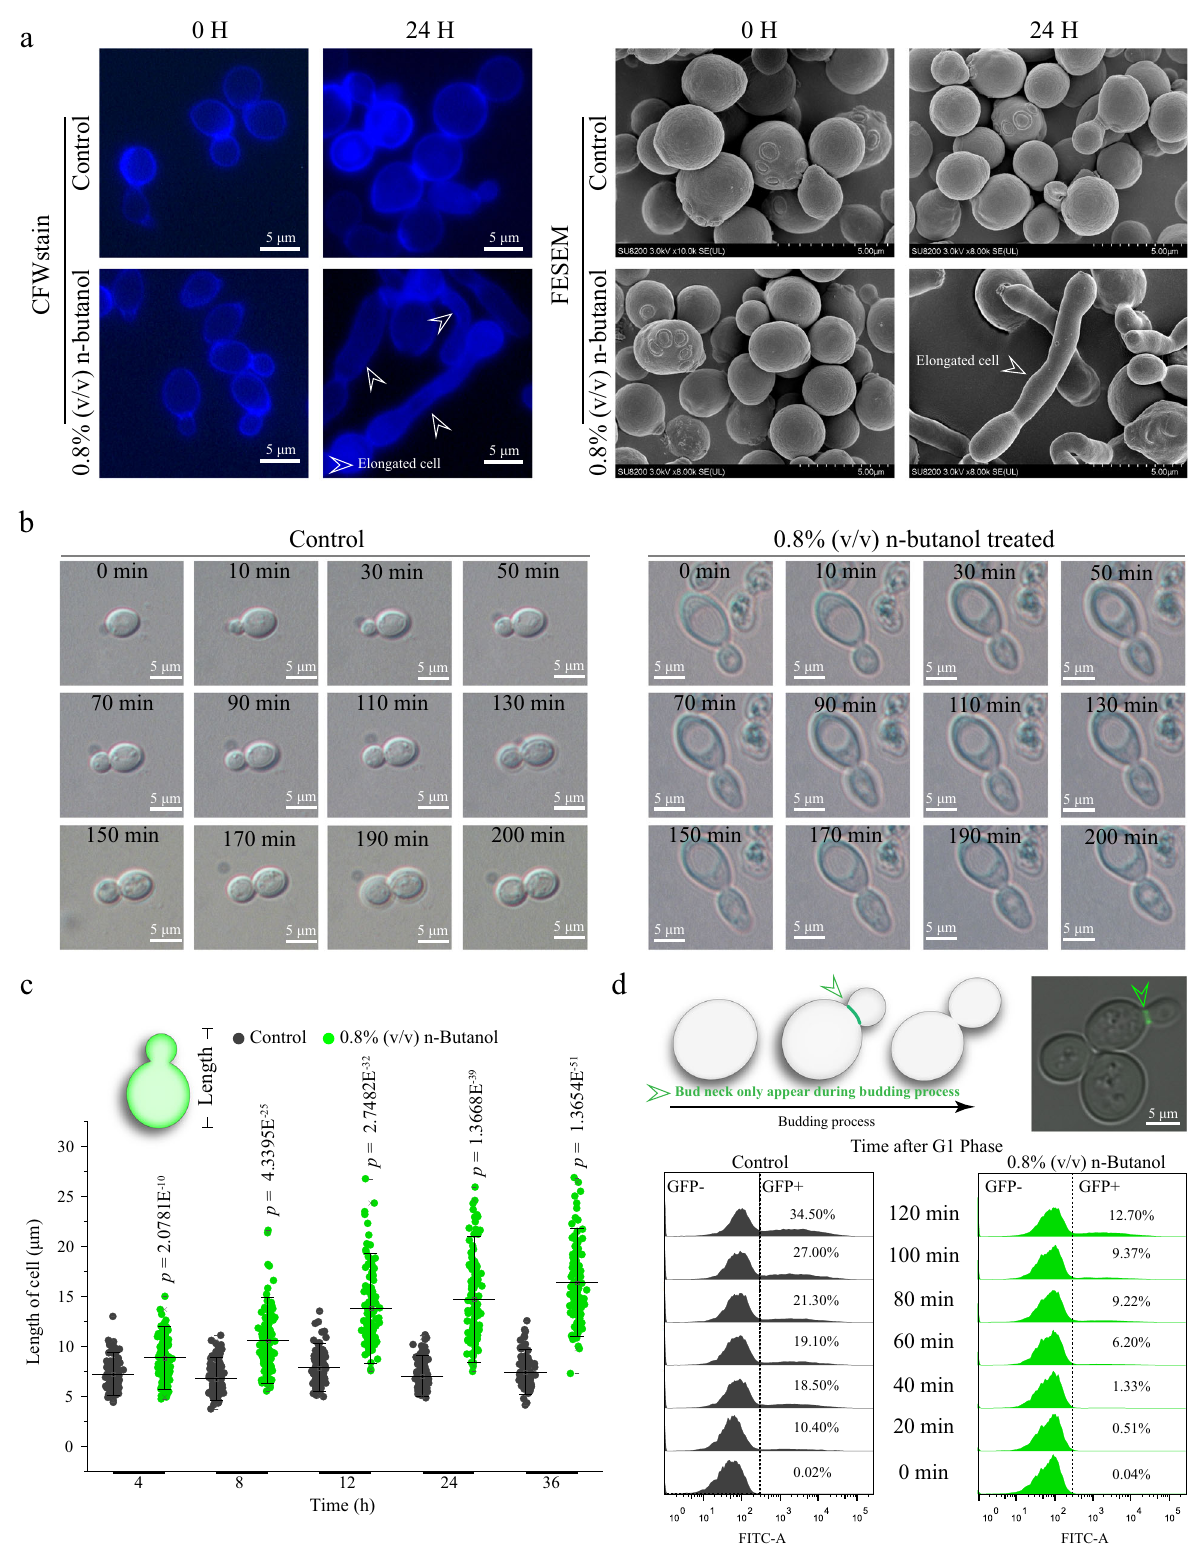
and 4.1%, respectively (Fig. 3b). Second, Cdc10-GFP (a fusion between a component of the septin ring and green fl uorescent protein) was used as a marker to visualize the budding index of yeast cells. As shown in Fig. 3c, the relative budding indices of Cdc10-GFP in the SPA2 deletion strain and the cdc42 over- expression strain were 14.0% and 15.3% higher than that of